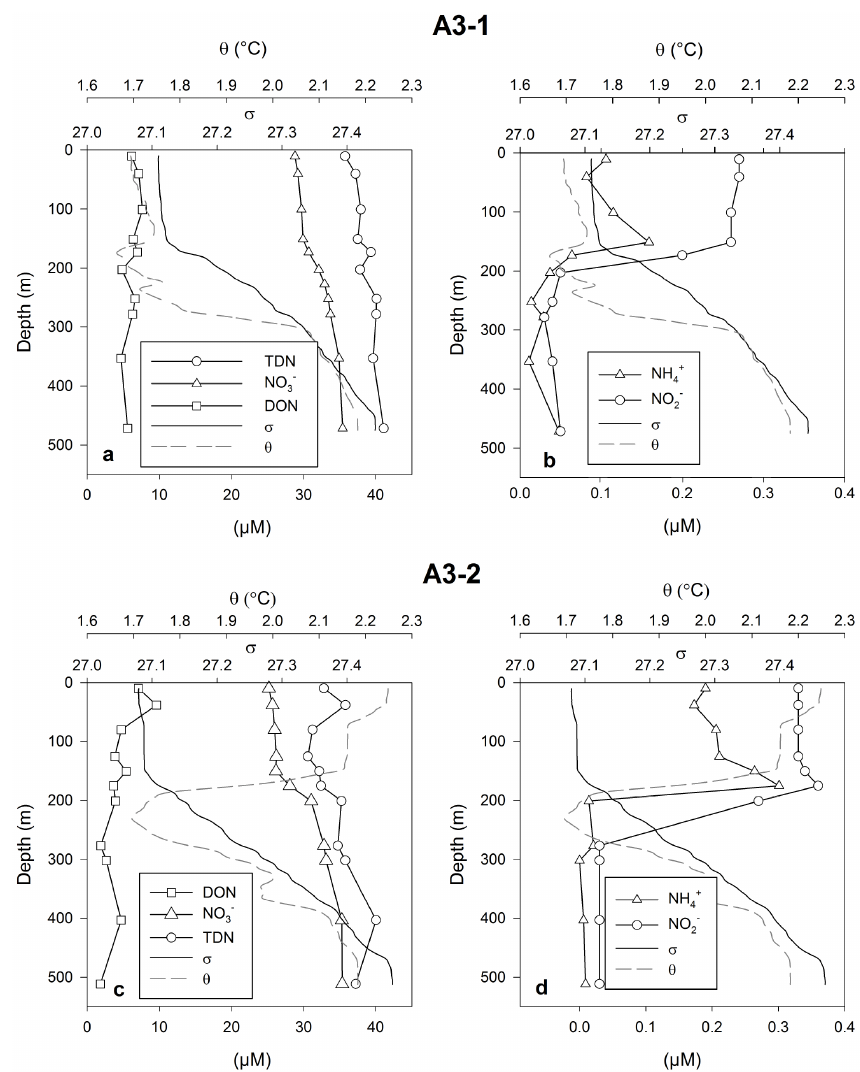
Figure 4. Dissolved nitrogen speciation at station A3-1 (a, b) and at station A3-2 (c, d) during KEOPS2. Depth profiles of temperature and σ – θ are plotted on each